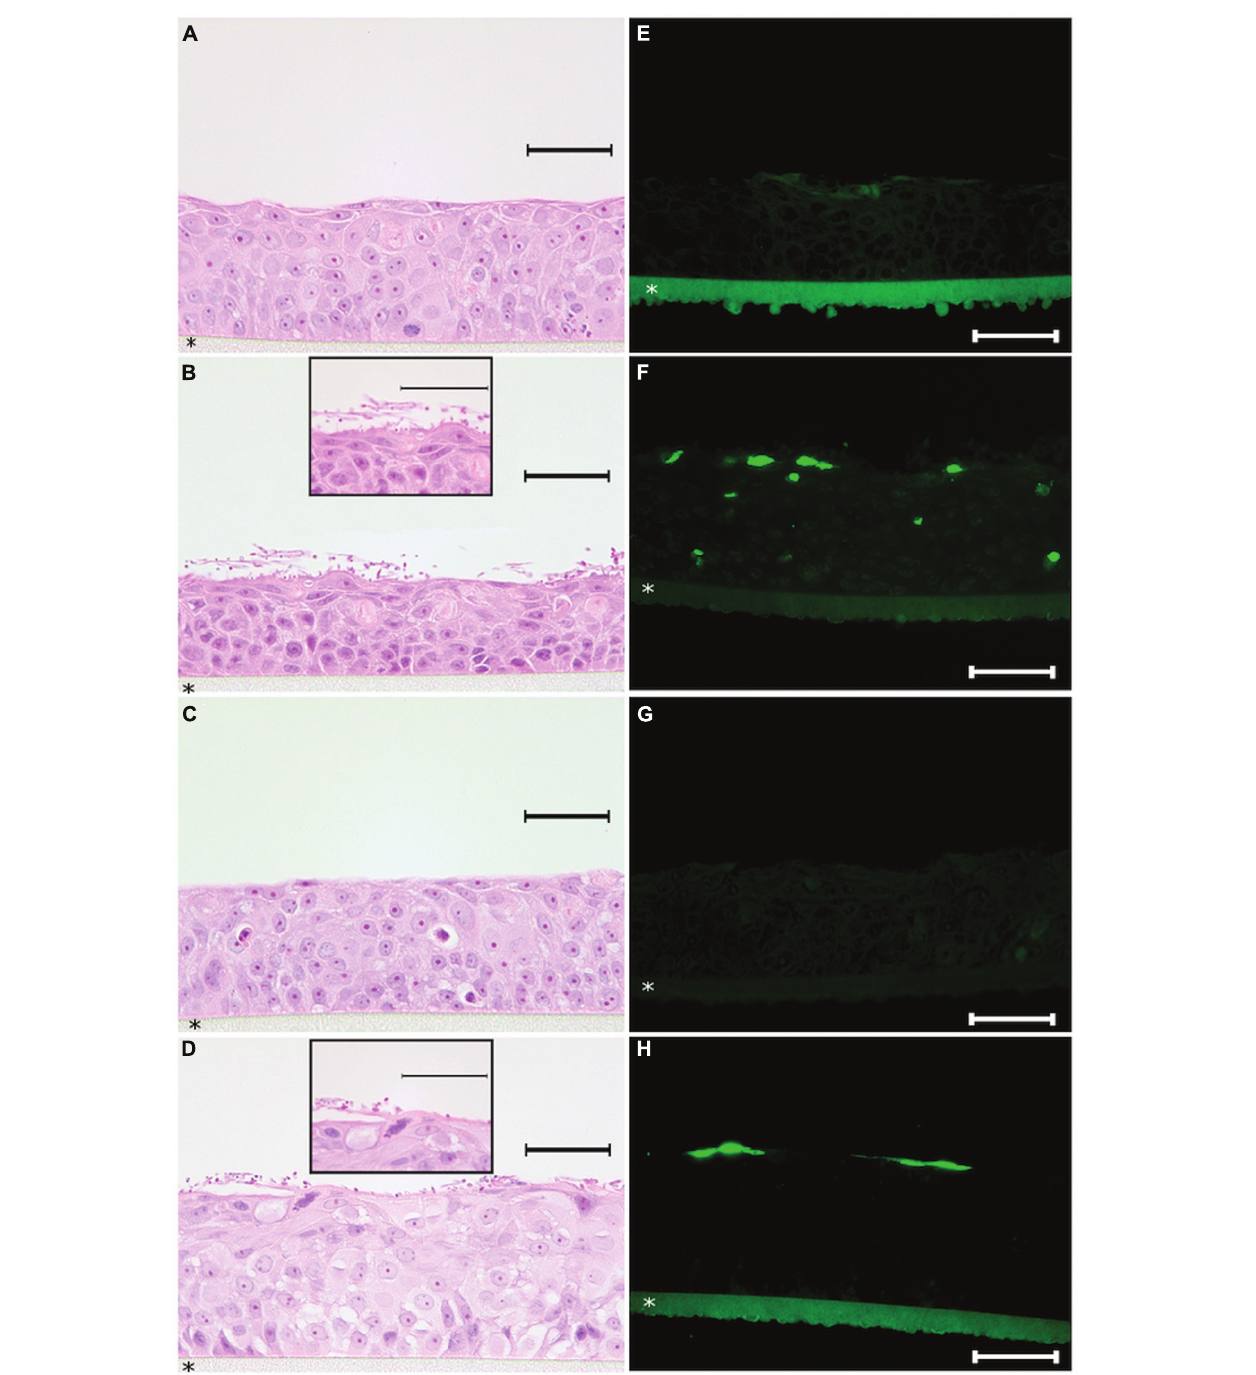
FIGURE 4 | Histopathology analysis of reconstructed human oral epithelium, exposed or not to histatin 5, both without C. albicans , exhibited a normal morphology (A,C) and no apoptotic cells (E,G). For the tissues exposed to C. albicans , hematoxylin and eosin (H&E) stained sections demonstrated efficient adherence of C. albicans on the outer layer of the reconstructed human oral epithelium (HOE; B,D ). In the group which was not treated with histatin 5, a higher number of C. albicans in hyphae form (B) was observed. Interestingly, for the group